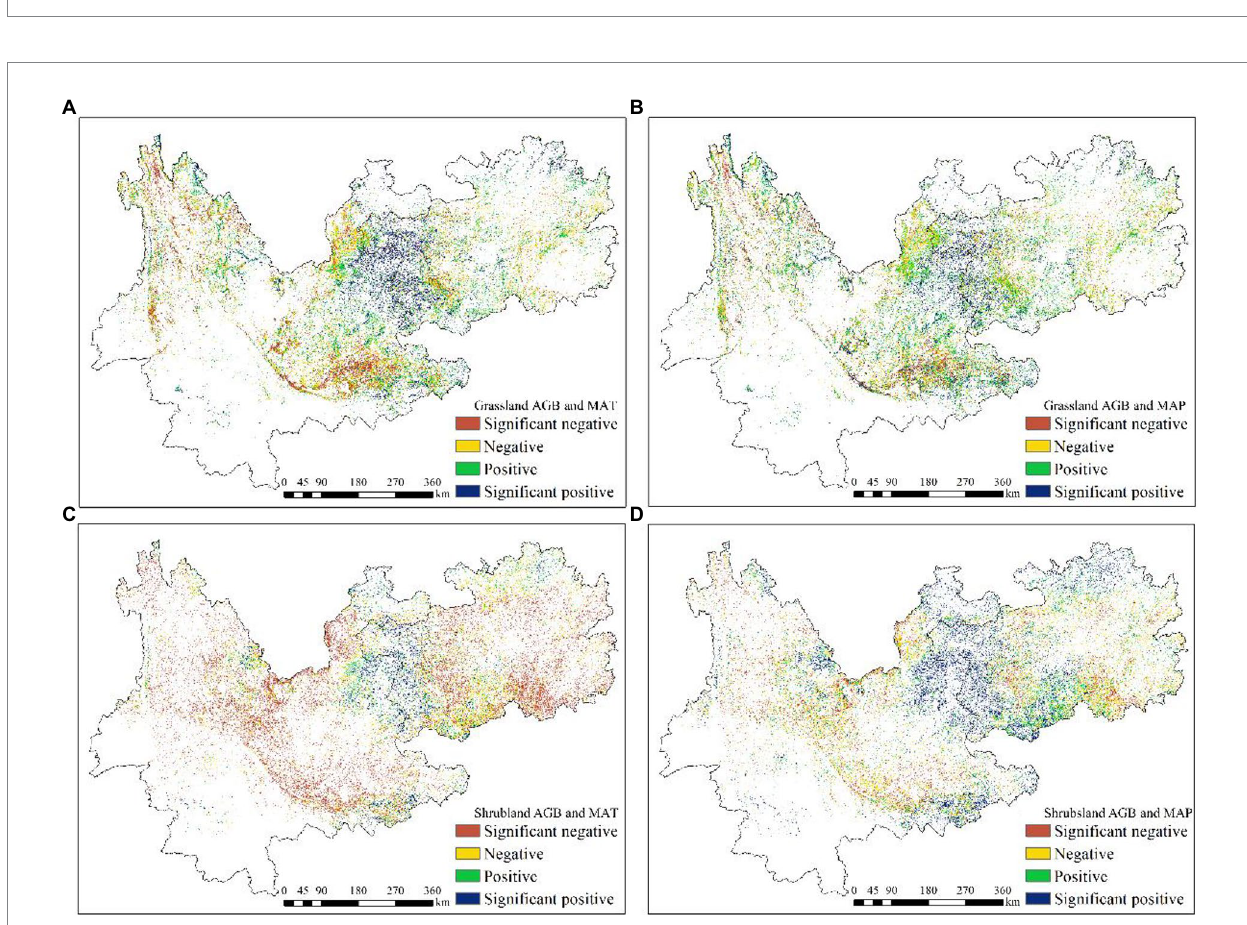
FIGURE 8 Partial correlation between grassland AGB and mean annual temperature (A) , grassland AGB and mean annual precipitation (B) , shrubland AGB and mean annual temperature (C) , shrubland AGB and mean annual precipitation (D) at the significance level of 0.05 from 2018 to